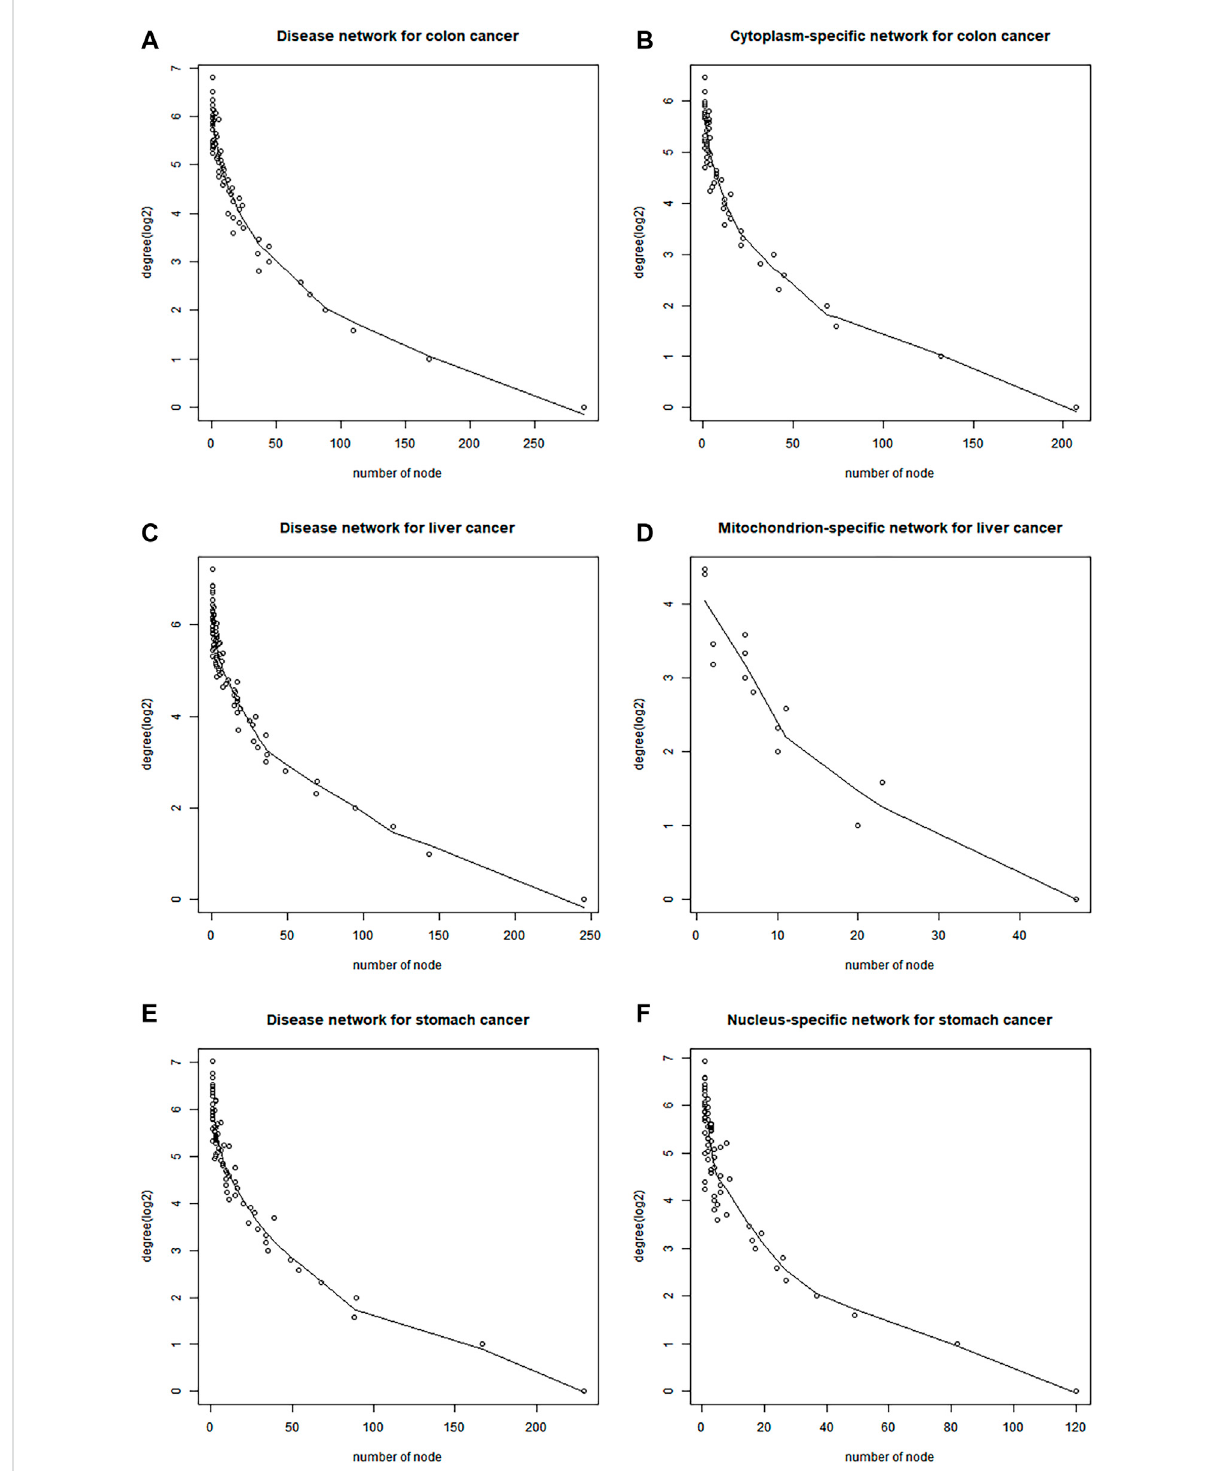
FIGURE 3 Degree distribution for part of disease networks and subcellular location-speci fi c networks for stomach, liver, and colon cancers. (A) Disease network for colon cancer. (B) Cytoplasm-speci fi c network for colon cancer. (C) Disease network for liver cancer. (D) Mitochondrion-speci fi c network for liver cancer. (E) Disease network for stomach cancer. (F) Nucleus-speci fi c network for stomach